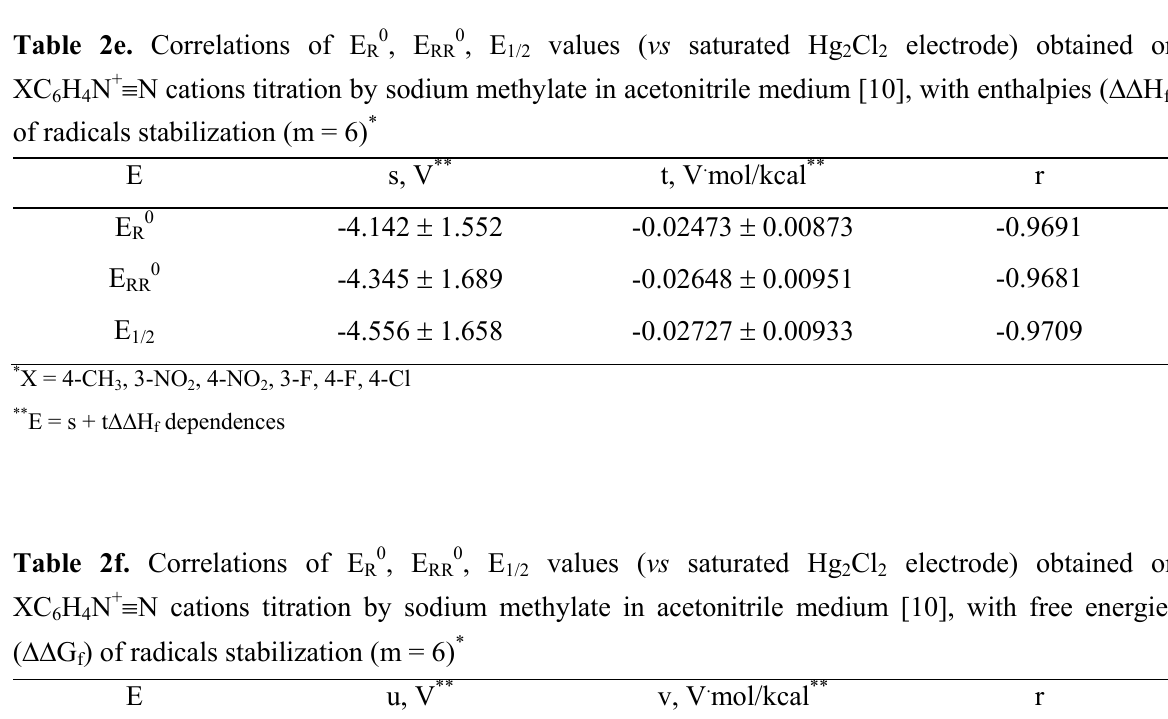
Table 2e. Correlations of E R0 , E RR0 , E